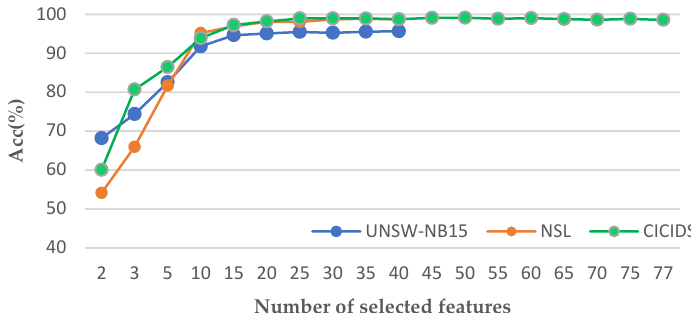
Figure 4. Different number of features and their corresponding testing accuracy on the NSL-KDD, UNSW-NB15 and CICIDS2017 datasets.